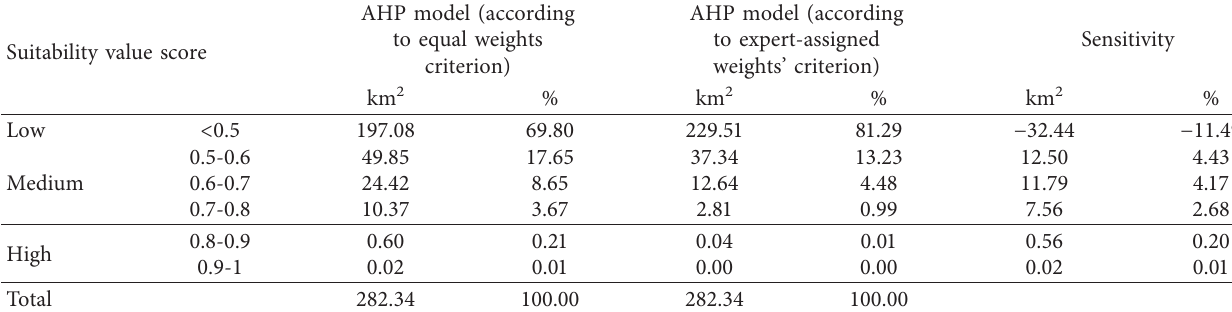
Table 6: Wind sensitivity analysis